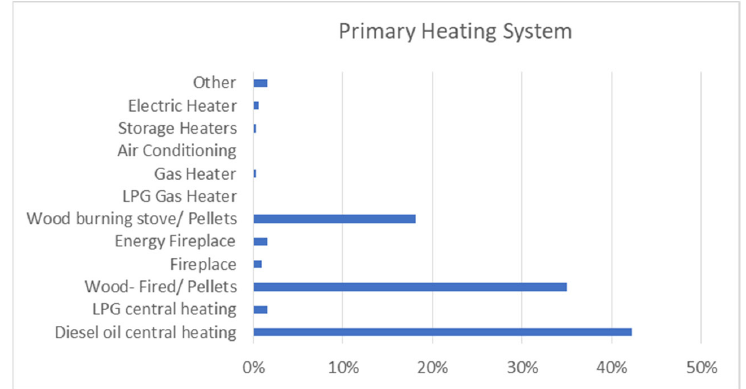
Figure 2. Primary heating systems used in Metsovo.